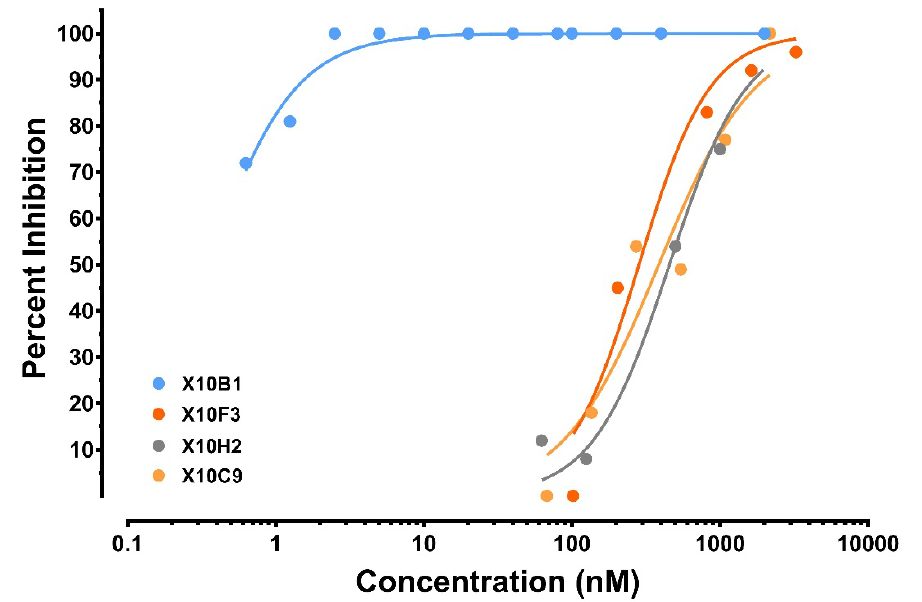
Figure 2. Down-selected antibodies neutralizing activity was evaluated by PRNT. Serially diluted mAbs were mixed in complete MEM supplemented with 10% FBS with SUDV at a constant viral titer of 65 pfu prior to adding in to Vero cells for a 1 h incubation. Wells were overlaid with 1% agarose in Eagle’s basal medium (EBME) with 10% FBS and 0.1% gentamicin and returned to the incubator On Figure 2: Antibody screening and down selection of optimal performers. Down-selected antibody neutralizing day 7, a 1% agarose secondary overlay containing 4% neutral red was added and after one more day at activity was evaluated by PRNT. Serially diluted mAbs were mixed with SUDV prior to adding in to Vero cells. 37 ◦ C, plaques were Fells were fixed 48 hours after infection.